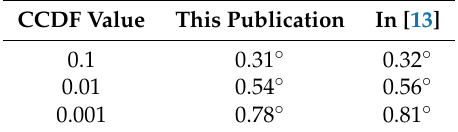
Table A1. Comparison of ME-angle errors extracted from the data in Figure A1.